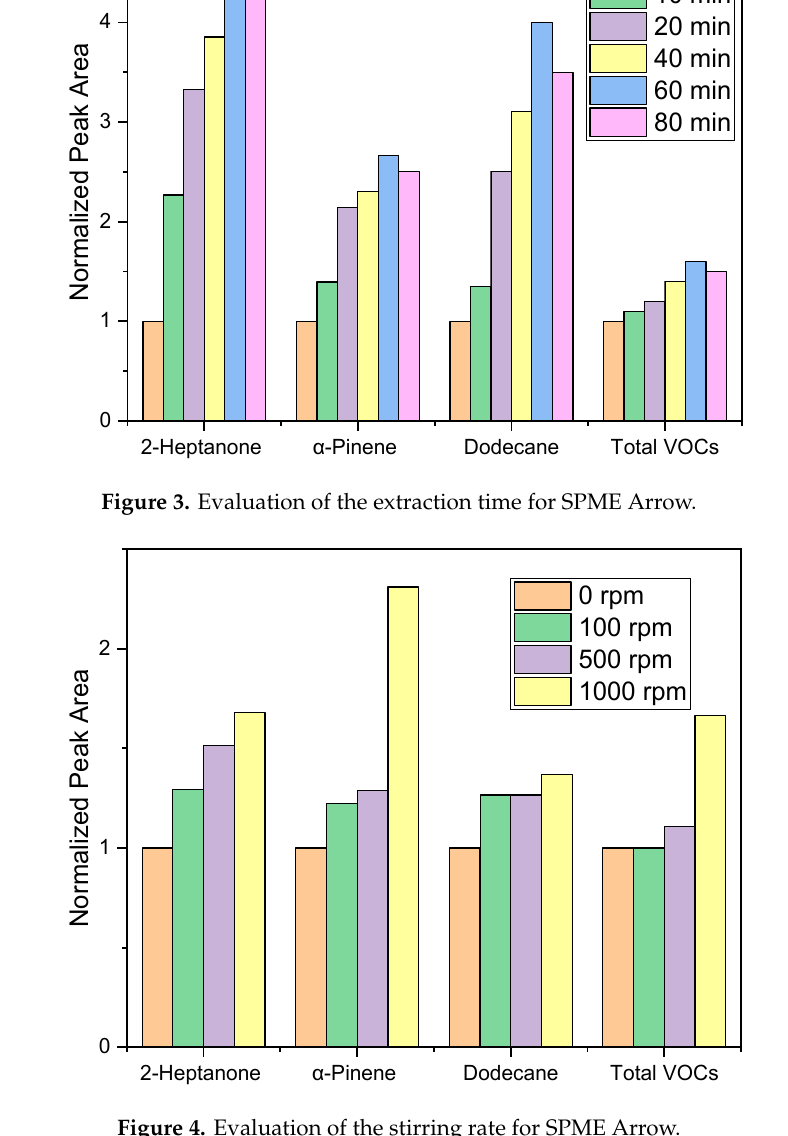
Figure 4. Evaluation of the stirring rate for SPME